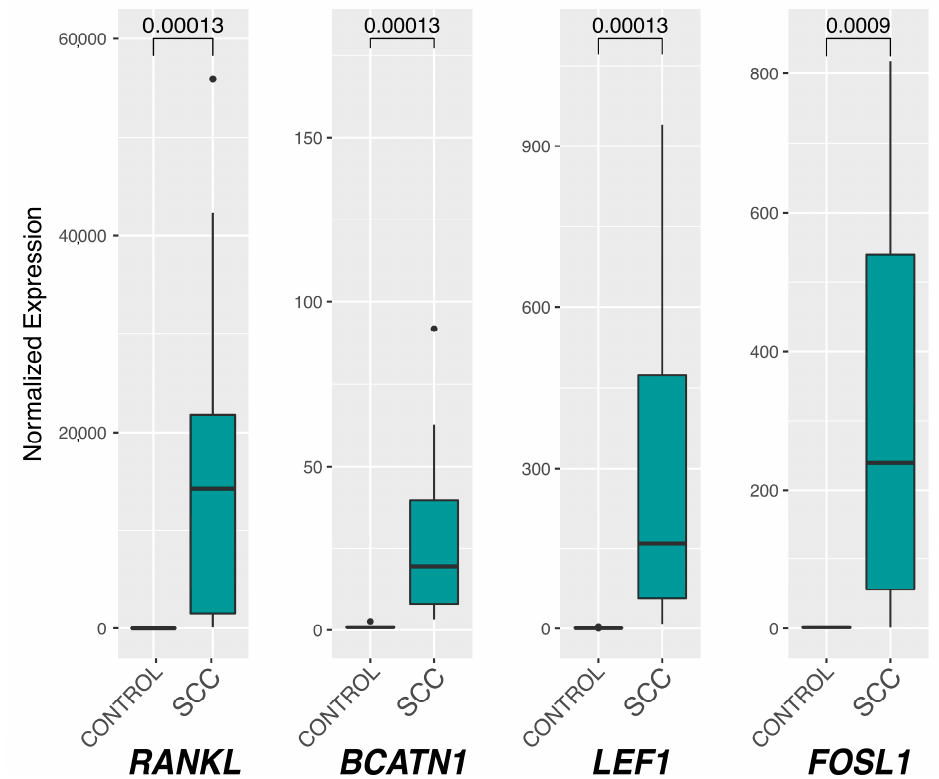
Figure 4. Box plot of RANKL , BCATN1 , LEF1 , and FOSL1 relative gene expression. The Mann–Whitney U test was used to assess the median differences between Control and SCC groups and their statistical significance ( p < 0.05, reported on the upper part of the graphs) after normalizing the expression levels with respect to those of the reference B2M . SCC: squamous cell carcinoma